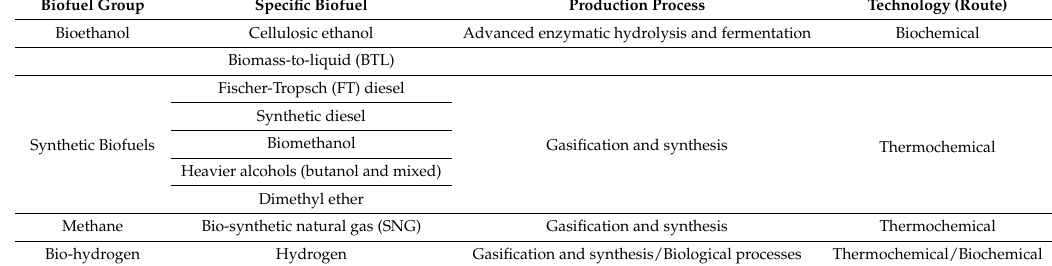
Table 2. Classification of second-generation biofuels from lignocellulosic feedstocks.